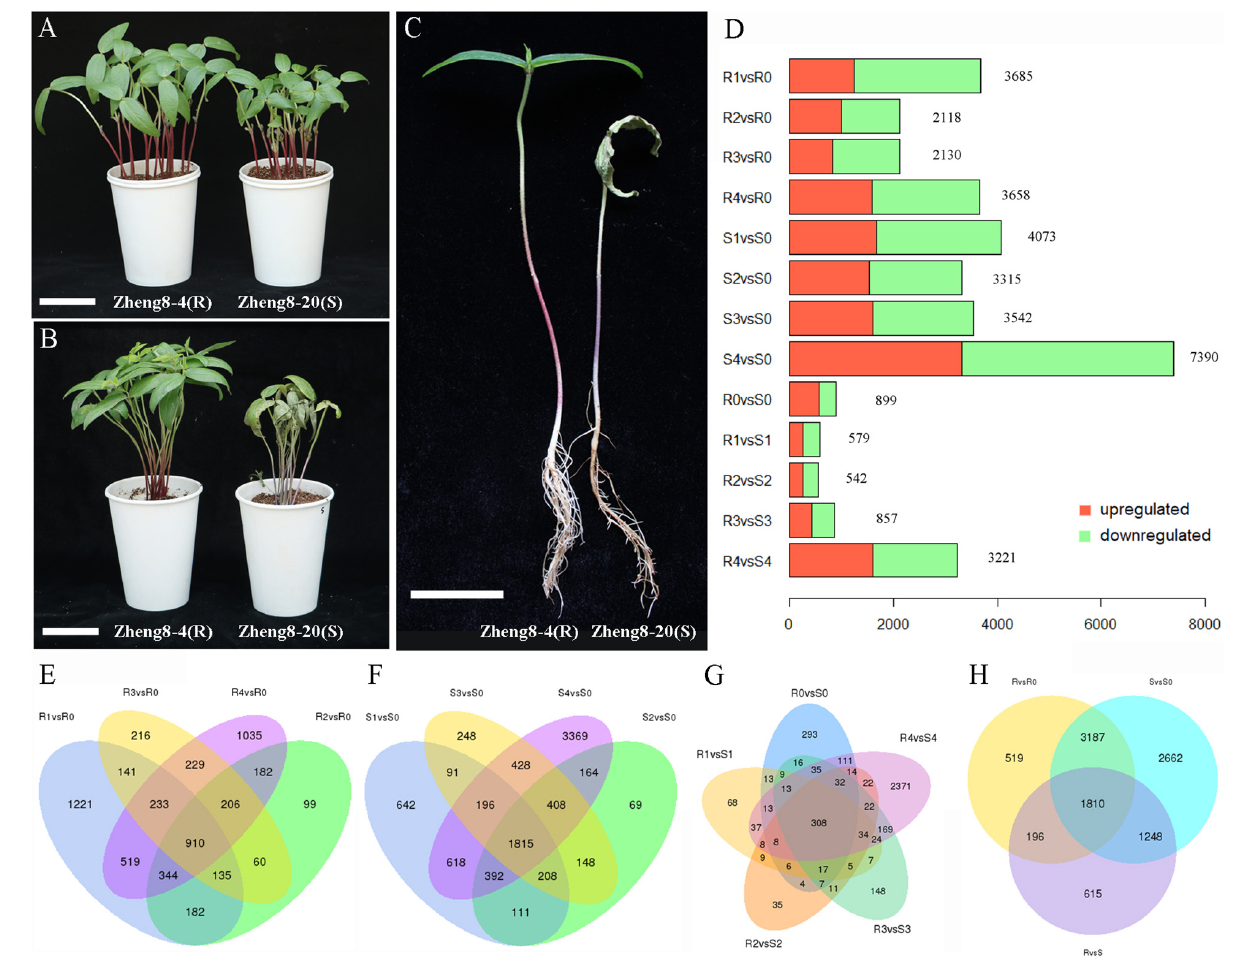
FIGURE 1 | Symptoms of Fusarium wilt and differential expression analysis in the resistant line (Zheng8-4) and the susceptible line (Zheng8-20). (A) The phenotype of two lines at 0 dpi. (B,C) The symptoms of Fusarium wilt at 14 dpi. Bars = 5 cm. (D) Number of differentially expressed genes (DEGs) in each pair. Red, upregulated DEGs; Green, downregulated DEGs. (E,F) Venn diagram of the DEGs before and after inoculation in the resistant (E) and susceptible lines (F) . (G) Venn diagram of the DEGs between the resistant and susceptible lines. (H) Venn diagram of the DEGs in the two DEG analyses. R, resistant line Zheng8-4; S, susceptible line Zheng8-20; 0–4, 0, 0.5, 1, 2, and 4 dpi,